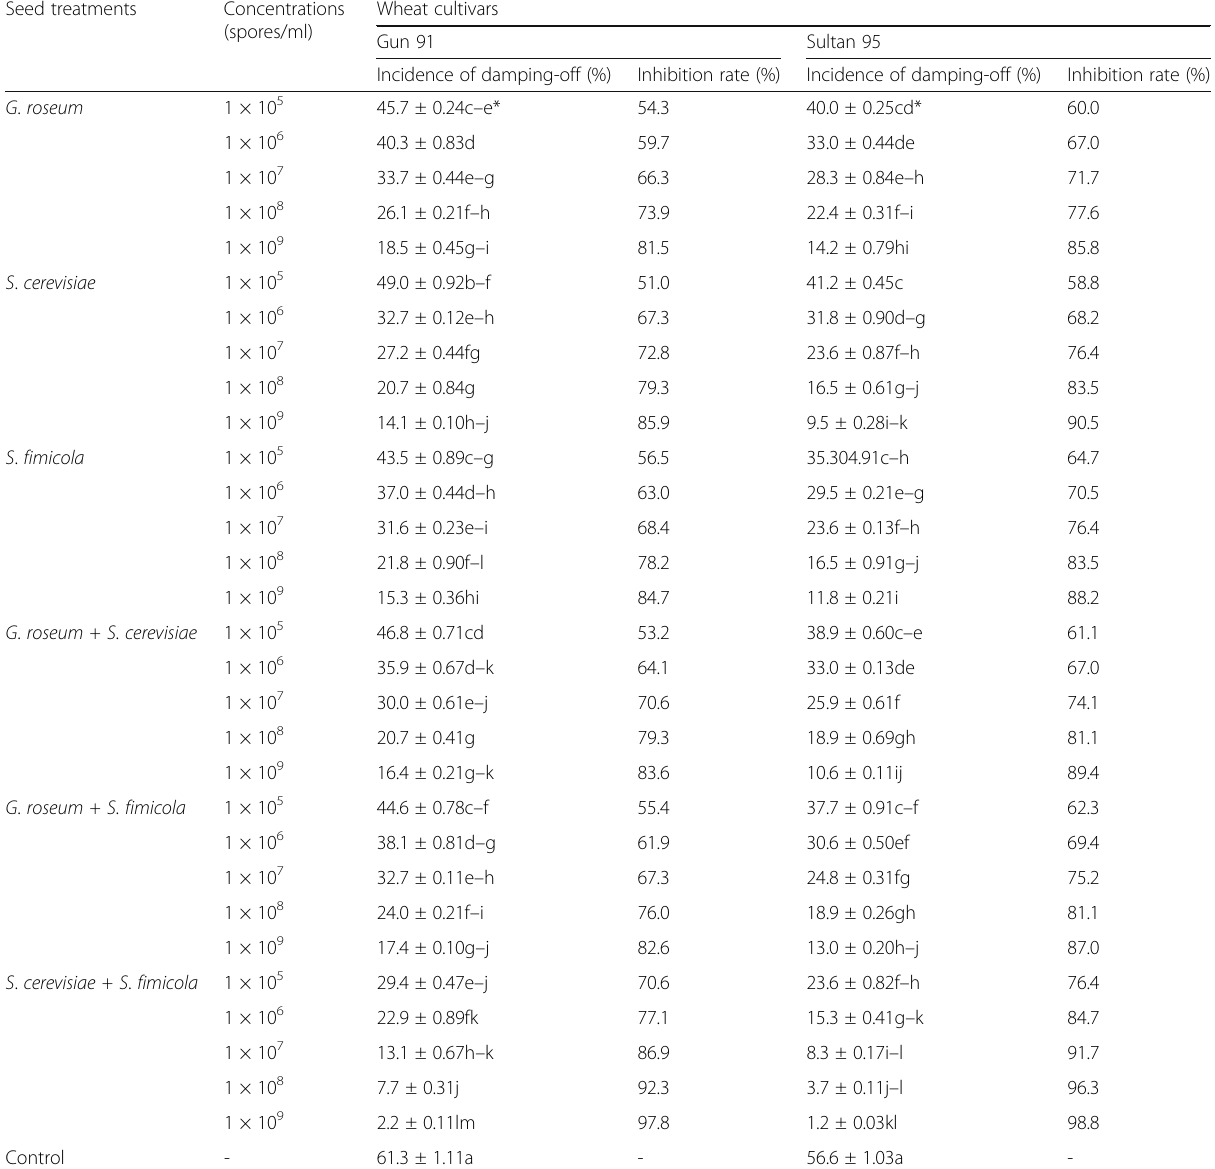
Table 3 Effect of different concentrations of the seed treatments on damping-off caused by F . graminearum in wheat cultivars Seed treatments Concentrations